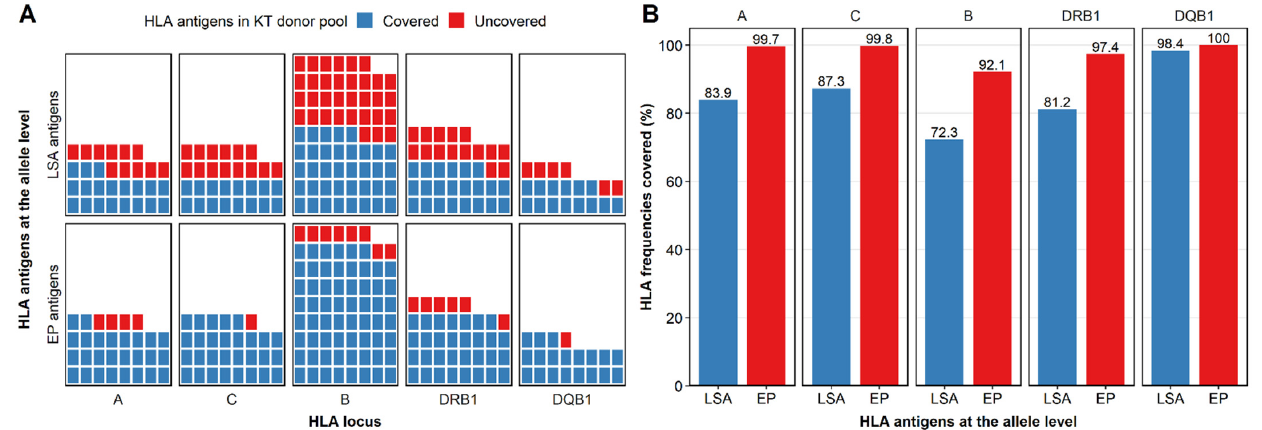
Figure 1. Comparison of donor HLA antigens covered by HLA antigens in the LIFECODES Single Antigen (LSA) kits (LSA antigens) and eplet-predicted antigens (EP antigens). ( A ) Counts of donor HLA antigens covered. Each tile represented an HLA antigen. HLA antigens covered and uncovered by LSA antigens or EP antigens were colored red and blue. ( B ) Frequencies of donor HLA alleles covered by LSA antigens (blue) and EP antigens (red).